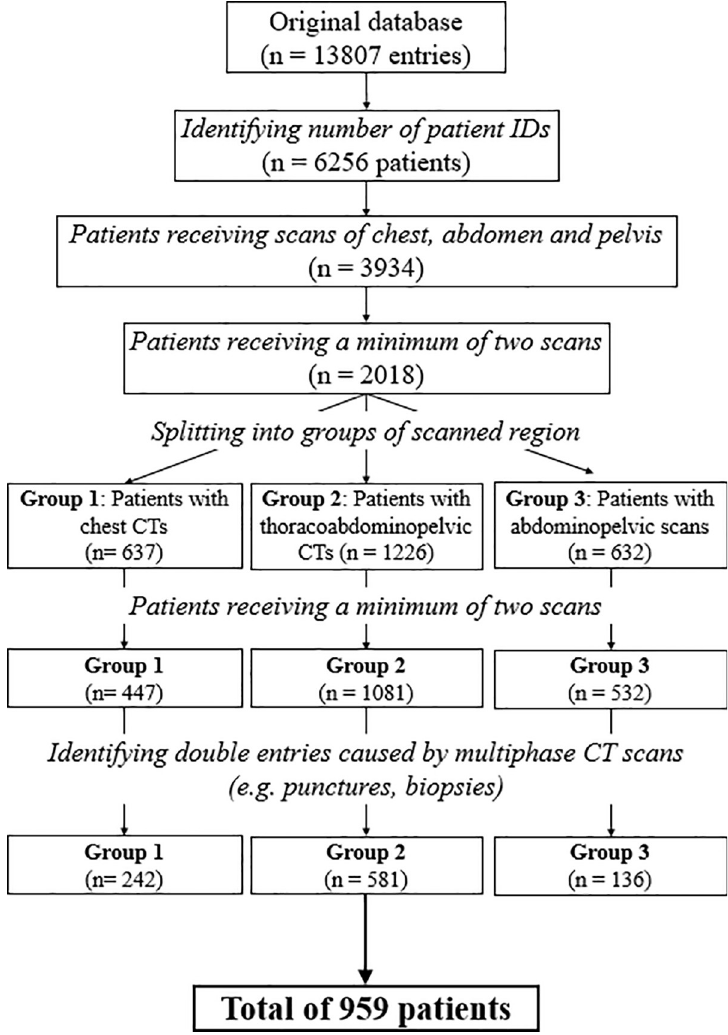
Fig 1. Flow diagram of the process filtering the included study population. Original database included all scans from March 2013 to December 2014 and was reduced and grouped to CTs of the chest, abdomen and pelvis.